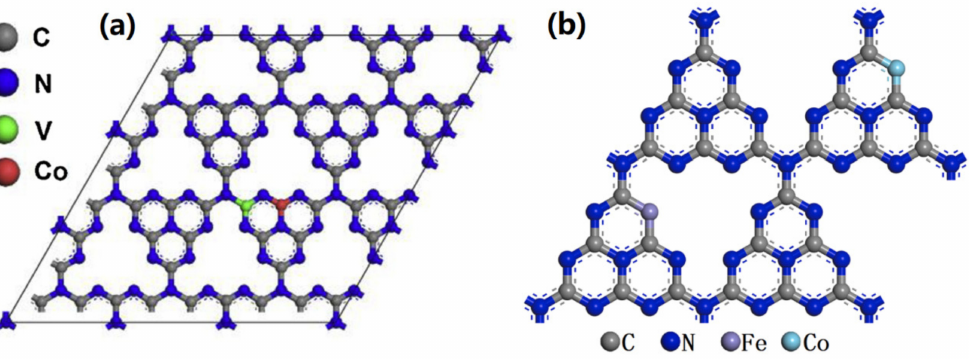
Figure 15. The models of ( a ) Co, V-GCN, and ( b ) Fe, Co-GCN. Reproduced with permission from Ref. [80].